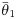
Optimal Flip Angles (FAs) for R1 mapping.FAs θ¯1 and θ¯2 of single- and double-GRE sequences that maximize the accuracy of R1 estimate as a function of the expected TR,0 ⋅ R1.